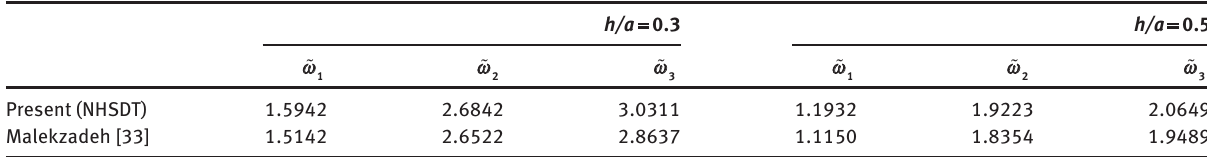
Table 8: Accuracy of the DQM in predicting the first three nondimensional frequency parameters ω (cid:31) = K = 0). K w s